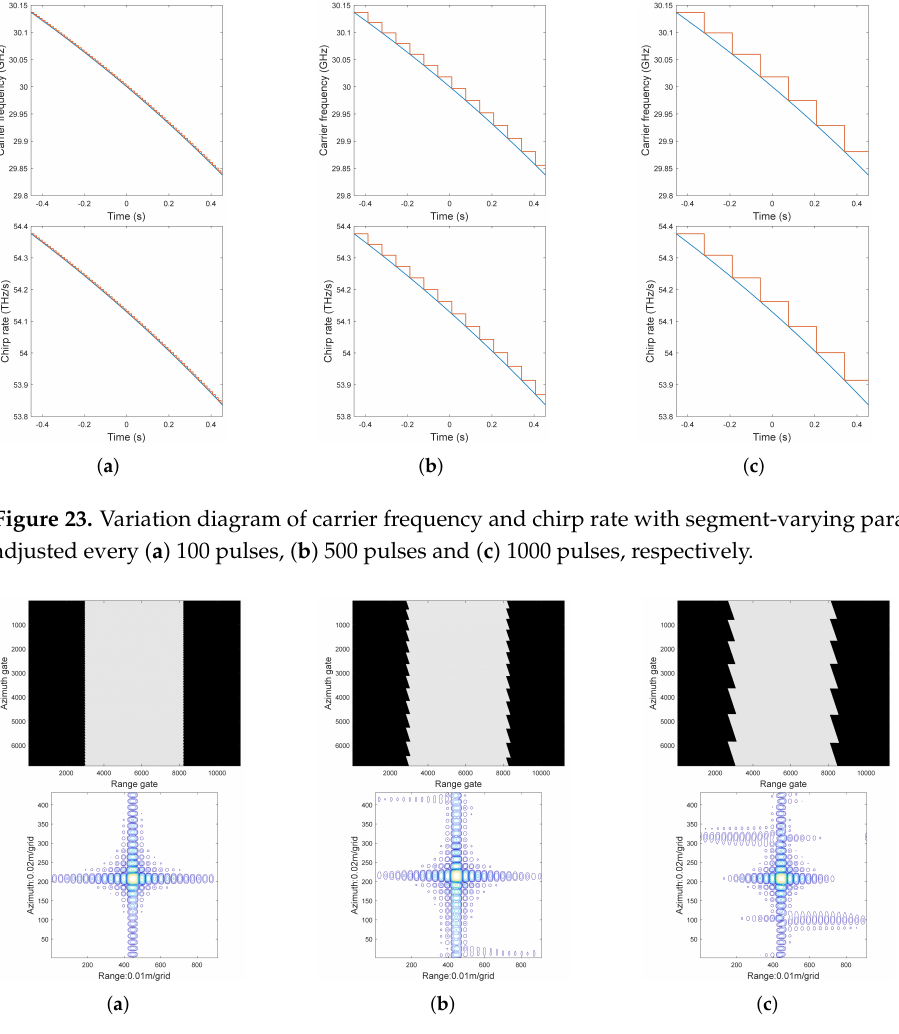
Figure 24. Wavenumber spectrums and two-dimensional point spread functions processed by two- layer ML-OSA with segment-varying parameters adjusted every ( a ) 100 pulses, ( b ) 500 pulses and ( c ) 1000 pulses,